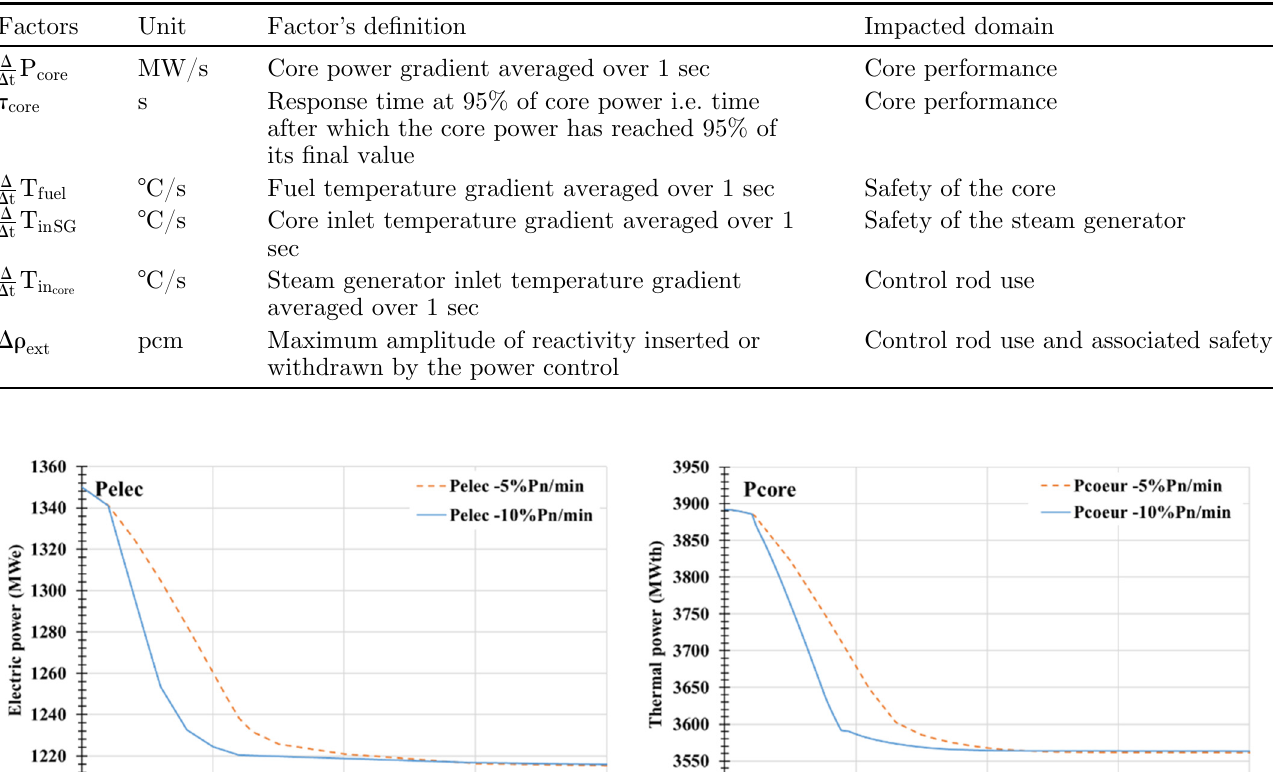
Table 3. Summary of selected factors.